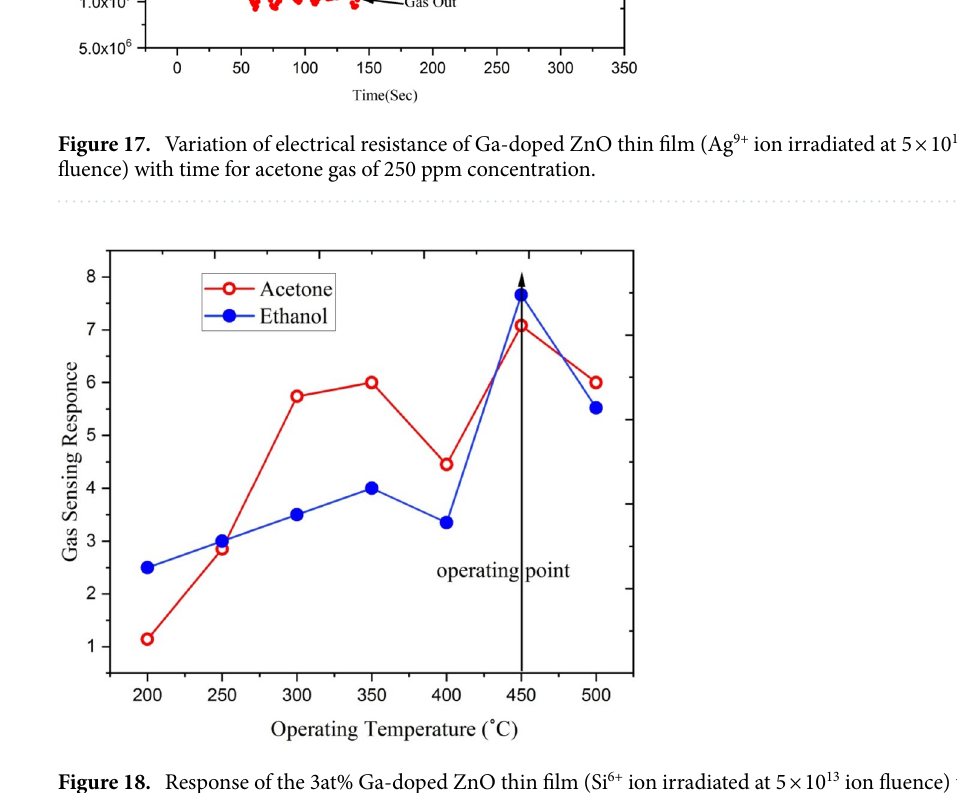
Figure 18. Response of the 3at% Ga-doped ZnO thin film (Si 6+ ion irradiated at 5 × 10 13 ion fluence) to 250 ppm ethanol and acetone concentrations at different operating